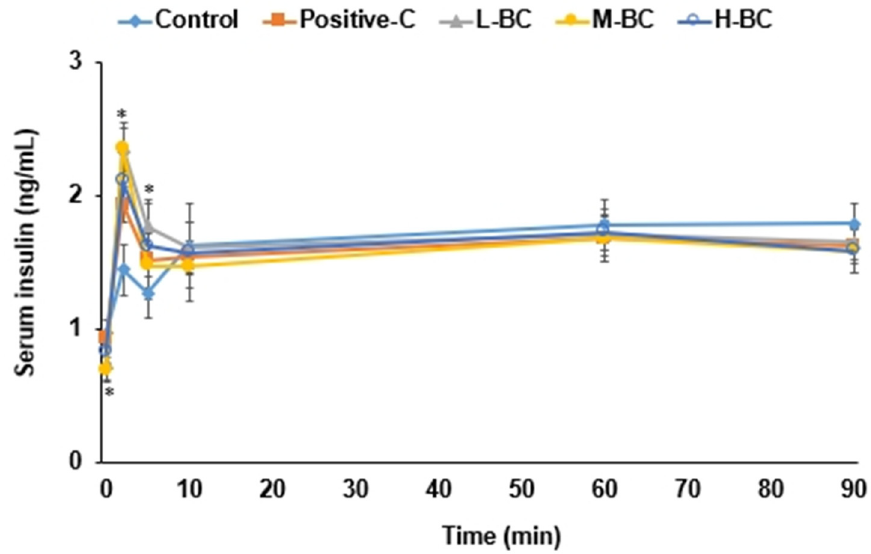
Figure 4. Insulin secretion during the hyperglycemic clamp. Partially pancreatectomized (Px) rats were fed a high-fat diet supplemented with 0% (control), 0.2% (L-BC; low dosage), 0.6% (M-BC; medium dosage), and 1.8% (H-BC; high dosage) blackcurrant extracts; 0.2% metformin (positive-C); plus 1.8%, 1.6%, 1.2%, 0%, and 1.6% indigestible dextrin. Hyperglycemic clamp testing was conducted on conscious, free-moving, or overnight-fasted rats to measure glucose-stimulated insulin secretion at the end of the eight-week experimental period. During a hyperglycemic clamp, exogenous glucose was infused into a jugular vein to produce serum glucose levels ~5.5 mM greater than in the fasting state, then blood was collected at 0, 2, 5, 10, 30, 60, and 90 min after infusion and serum insulin levels were measured. Each dot and error bar represents a mean and standard deviation, respectively ( n = 10). * Significantly different among the groups at p <